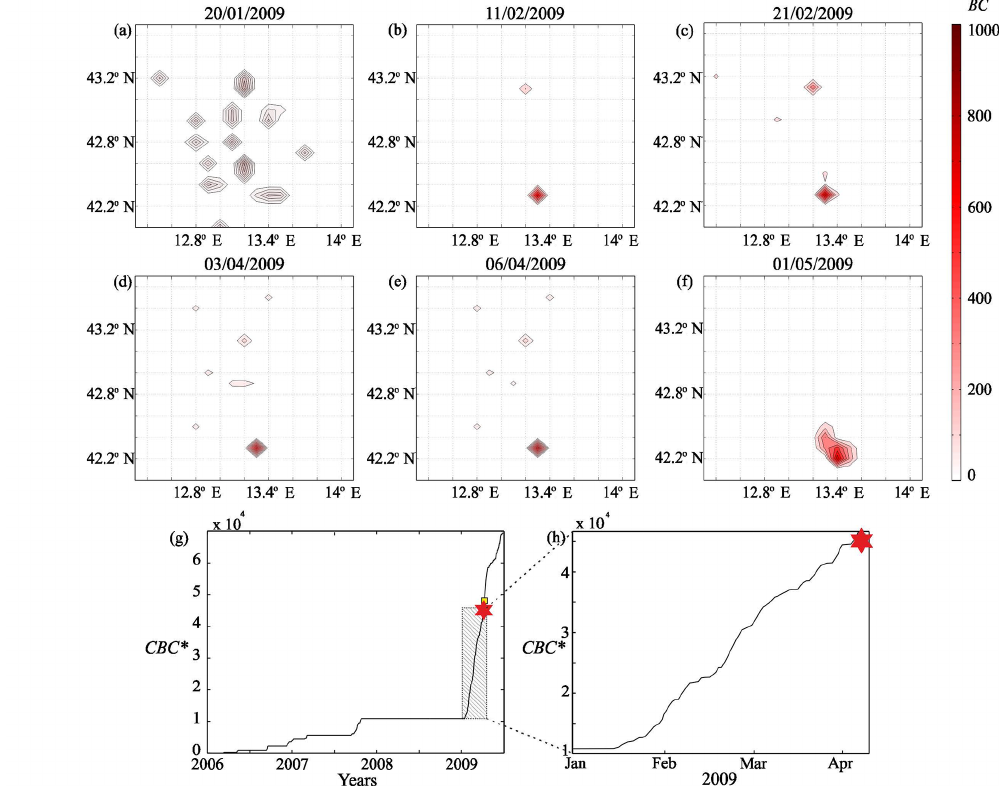
Figure 8. BC computations in the space window centered at 42.00 ◦ N, 13.30 ◦ E (off the center of the epicenter) with radius R 1 = 1 ◦ . The mainshock occurred on 6 April 2009 (red star): (a–i) snapshots of the BC maps for each cell from 20 January to 1 May 2009; (a–e) BC maps before the mainshock. (f) Cumulative BC computed at the mainshock cell (CBC ∗ ) from 1 January 2006 to 30 June 2009 (g) , and from 1 January to 6 April 2009 (h)